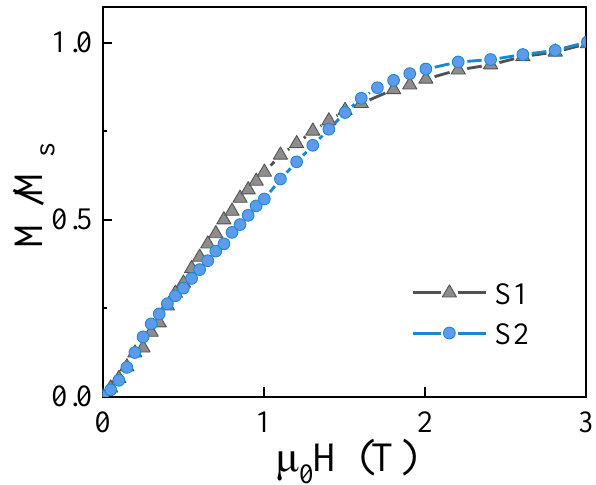
Figure 4. Normalized initial magnetization curves of both S1 and S2 samples.